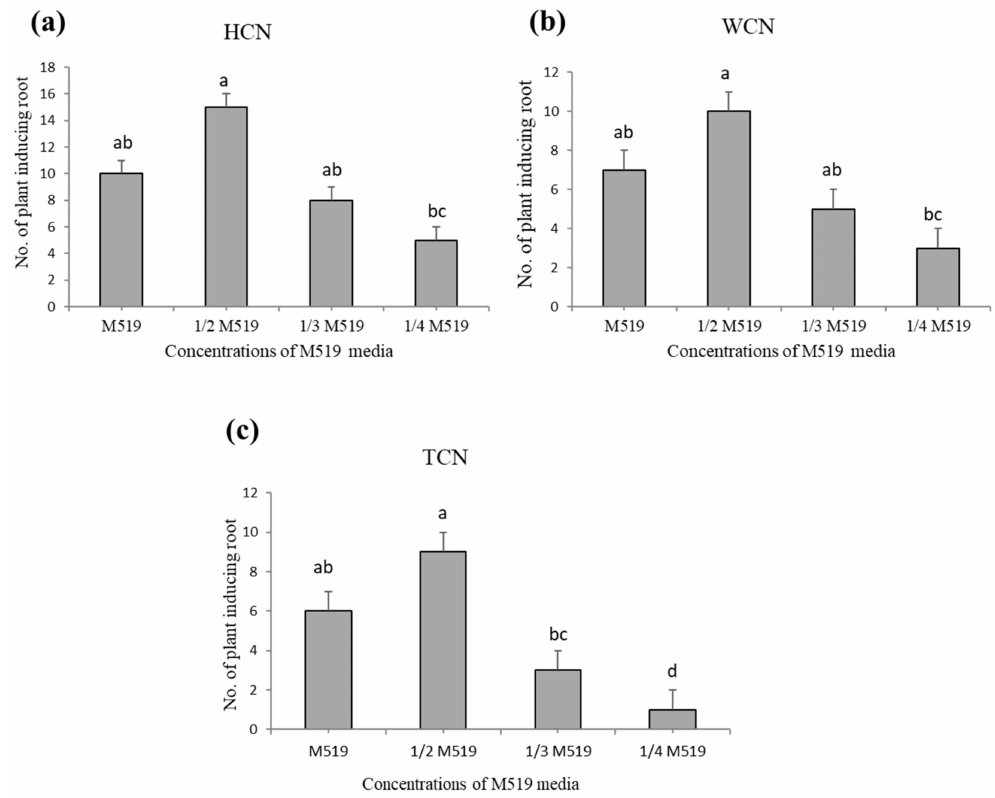
Figure 6. Root induction of Lupinus albus from three di ff erent explants on four di ff erent ratios of M519 media. ( a ) HCN (half cotyledonary node), ( b ) WCN (whole cotyledonary node), ( c ) TCN (traditional cotyledonary node). Di ff erent letters show significant di ff erences at p 0.05. Data shown represent mean ± standard error of four